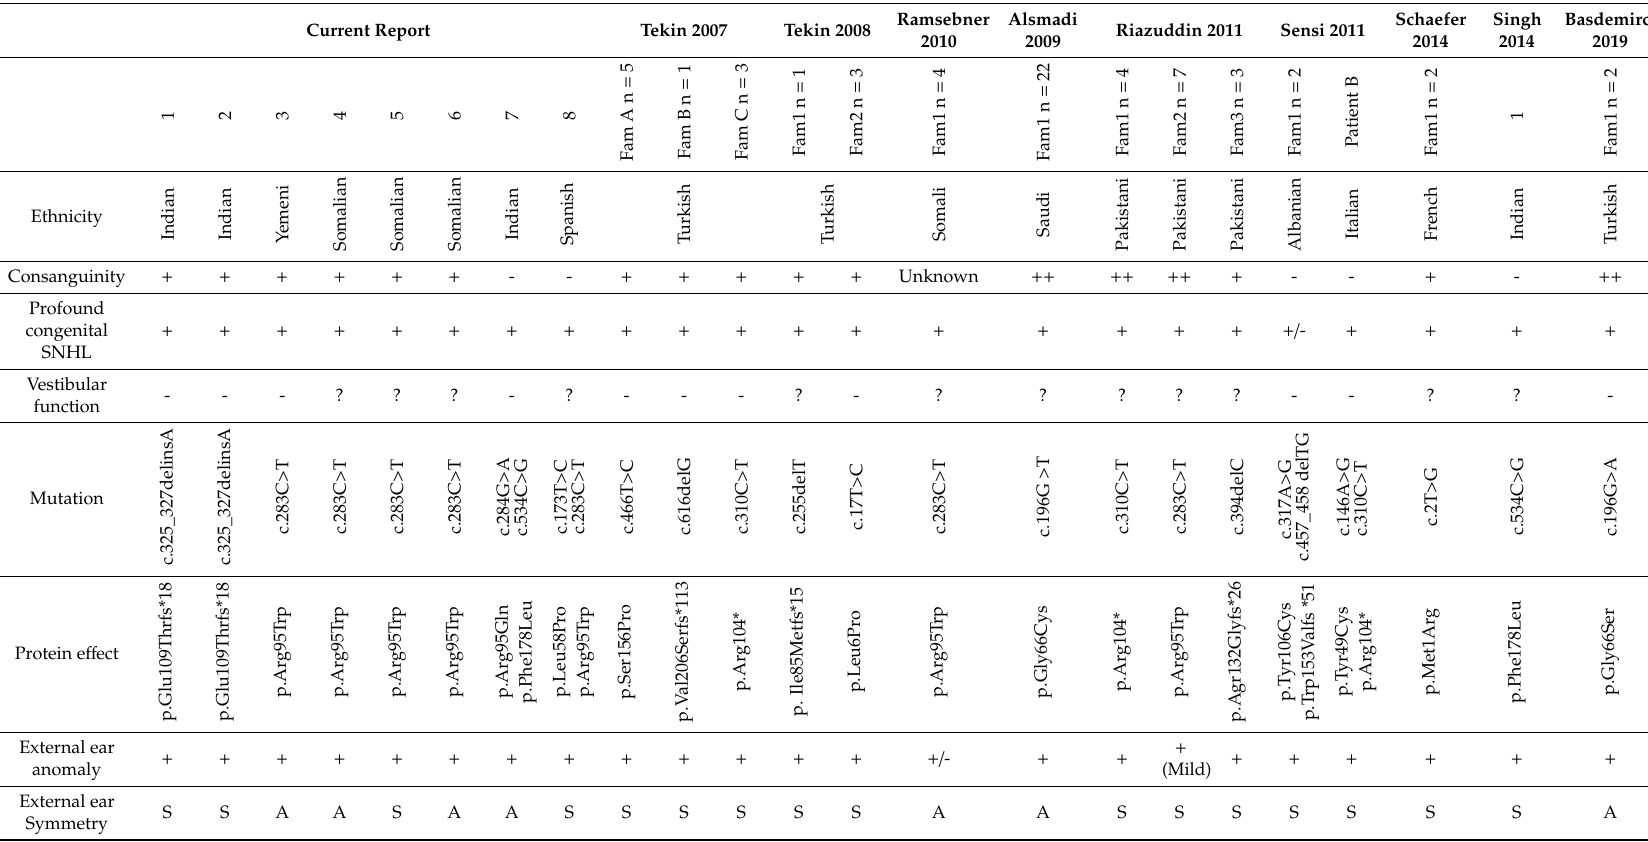
Table 2. Comparison of the phenotypic findings and mutations of our eight patients with previously reported LAMM cases. Current